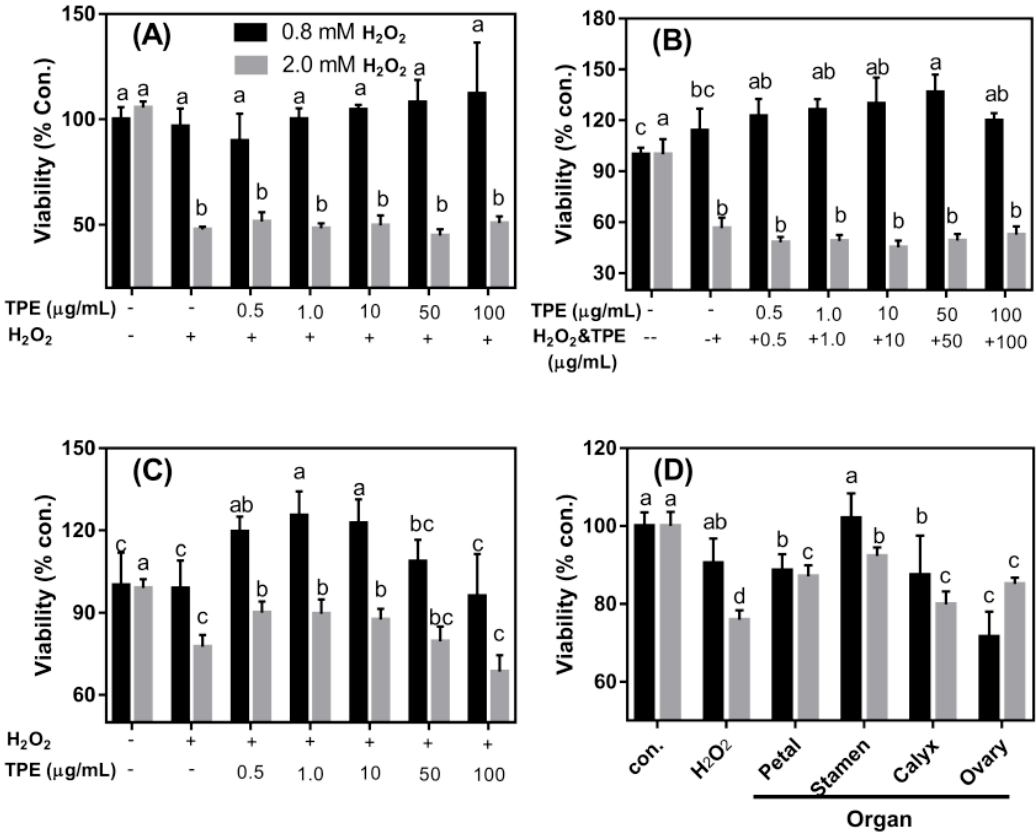
Figure 3. The preventive e ff ect of total phenolic extract (TPE) on Caco-2 cell viability decrease induced by H 2 O 2 . ( A ) Cells were treated with di ff erent TPE concentrations for 1 h, and then 0.8 or 2.0 mM H 2 O 2 was added for a treatment lasting 1 h, respectively. ( B ) Cells were treated with TPE for 1 h and then di ff erent concentrations of TPE plus 0.8 or 2.0 mM H 2 O 2 were added for a treatment lasting 1 h, respectively. ( C ) Cells were treated for 1 h with 0.8 or 2.0 mM H 2 O 2 , followed by treatment with di ff erent TPE concentrations lasting for 4 h. ( D ) Cells were treated for 1 h with 0.8 or 2.0 mM H 2 O 2 , and then treated for 4 h with 1 µ g / mL TPE from di ff erent organs. For H 2 O 2 treatment, cells were first treated with 0.8 or 2.0 mM H 2 O 2 for 1 h, and then treated for 4 h with a regular medium. The control was not treated with TPE or H 2 O 2 containing 0.1% dimethyl sulfoxide (DMSO). The TPE used in Figure A, B, and C was extracted from the whole flower using 80% methanol. The TPE in Figure D was extracted from four di ff erent organs. Data are expressed as mean ± SD. The con. means negtive control (no H 2 O 2 or TPE treatment). Di ff erent lower case letters indicate significant di ff erence at p < 0.05 for each